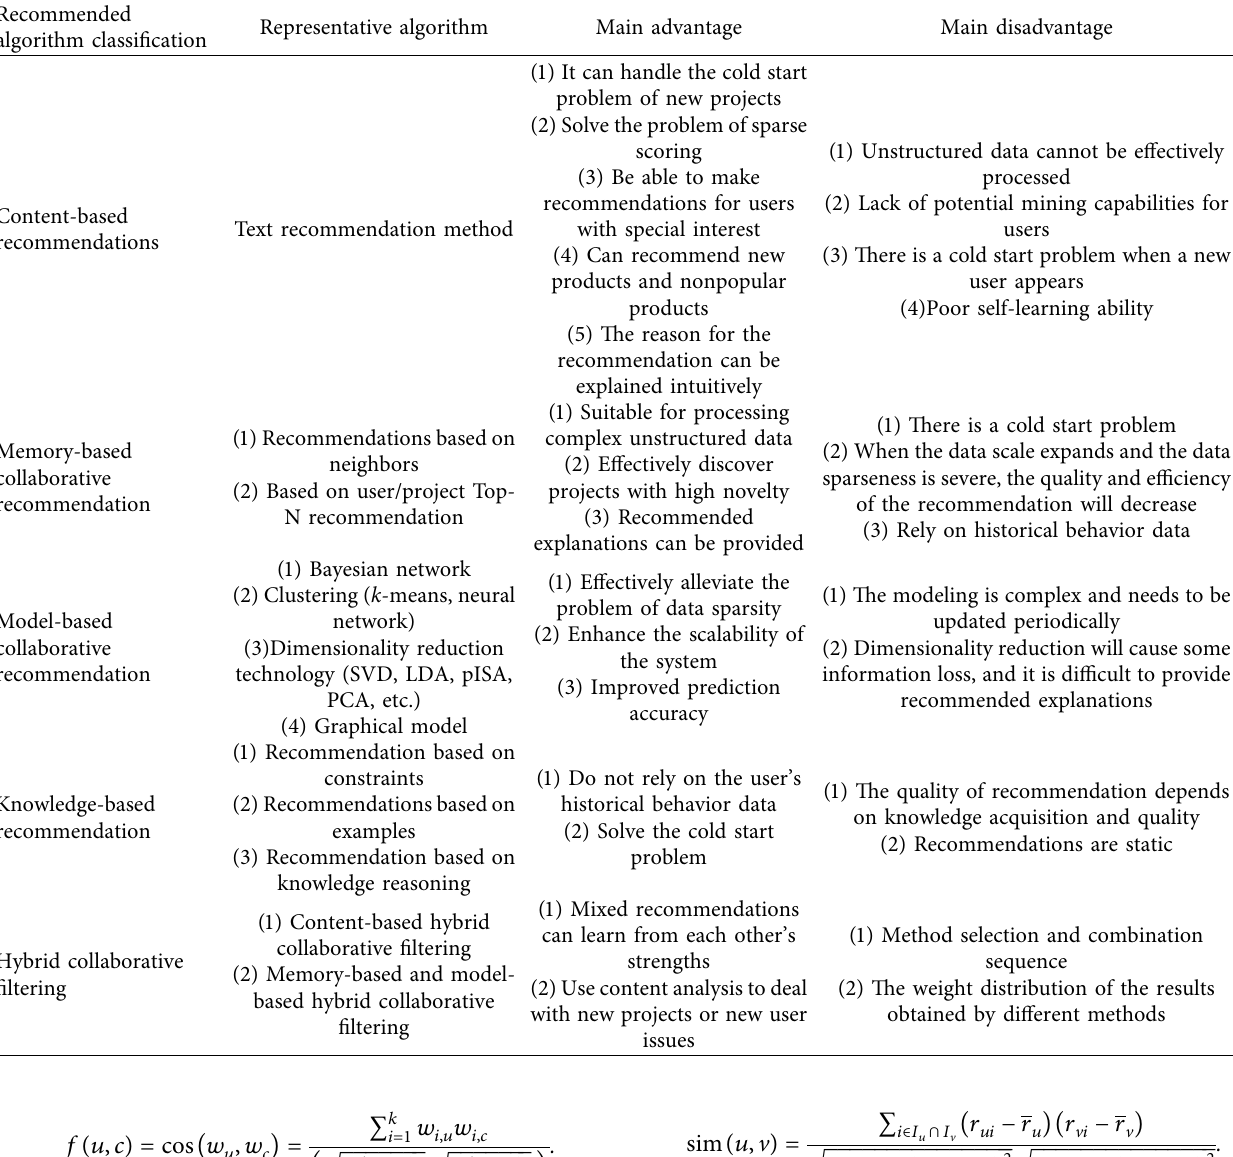
Table 1: The advantages and disadvantages of commonly used recommendation